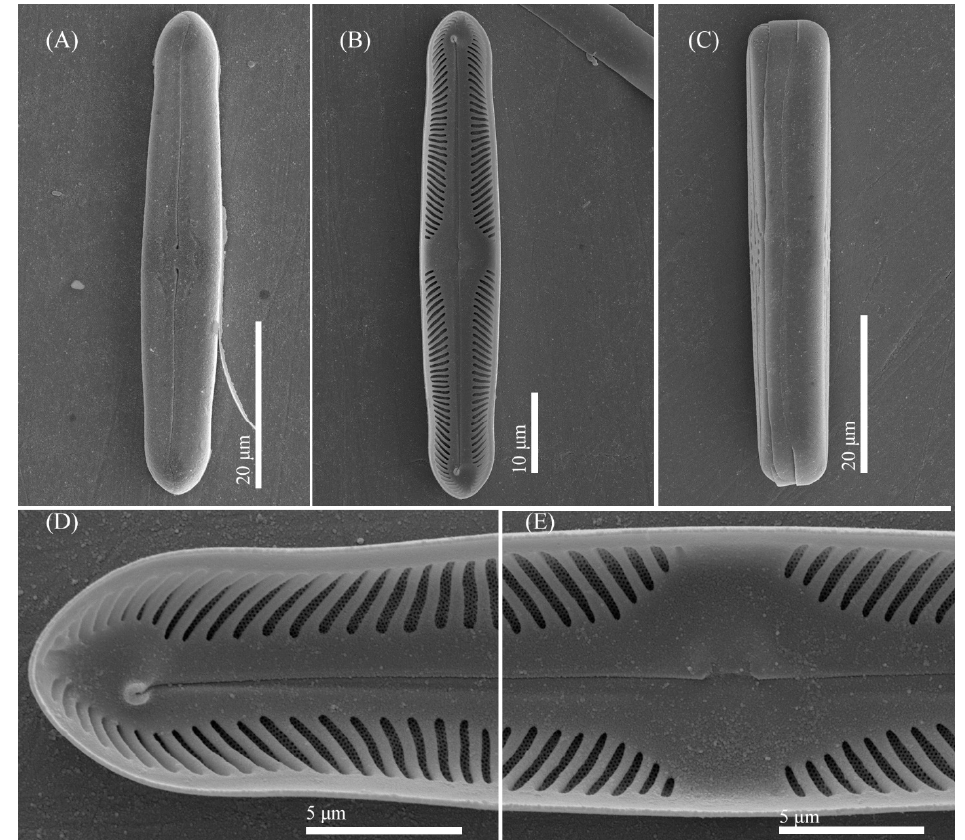
Figure 12. Pinnularia ministomatophora Kezlya, Maltsev, Krivova et Kulikovskiy sp. nov. Strain VP236 sample No. 06994. Scanning electron microscopy. ( A ) Exterior of the valve with the grooves on both sides of the raphe. ( B , D , E ) Internal views. ( C ) С ell in girdle view. ( E ) Central area. ( D ) Valves ends face.